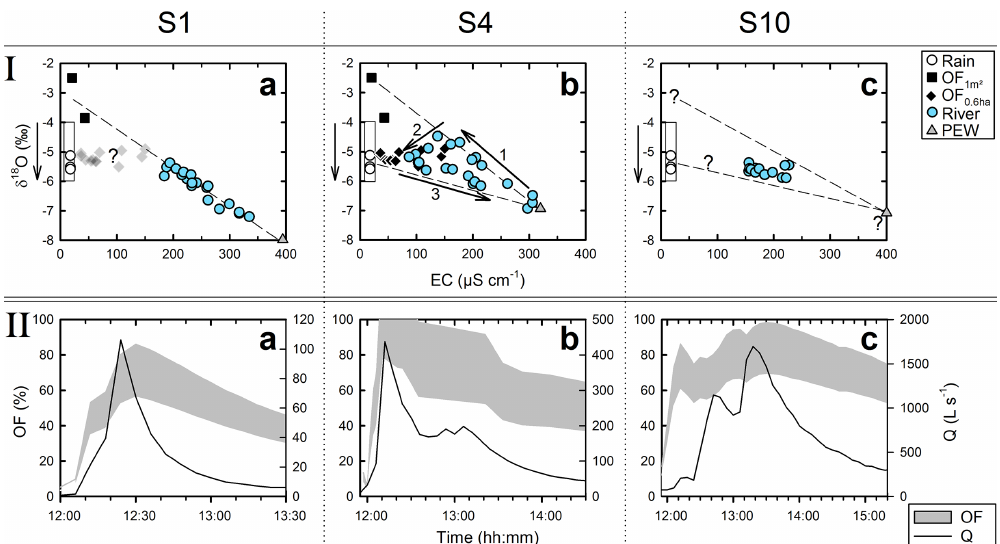
Figure 4. Plots of: (I) relationships between water electric conductivity (EC) and water δ 18 O, and (II) temporal evolution of stream water discharge ( Q ) with overland flow contribution estimates (OF) for (a) the upstream station S1, (b) the intermediate station S4, and (c) the downstream station S10, during the 23 May 2012 flood. In (I), open circles correspond to rainwater, filled squares to cumulative overland ) , filled diamonds to overland flow from S7 and S8 hillslopes (OF 0 . 6ha ), filled coloured circles to flow obtained with 1m 2 plots (OF 1m 2 stream water, and triangles to pre-event water (PEW). The rectangle areas and vertical arrows represent the potential temporal variability of rainwater- δ 18 O during the storm. In (II), the shaded area corresponds to the variability range for the estimated overland flow